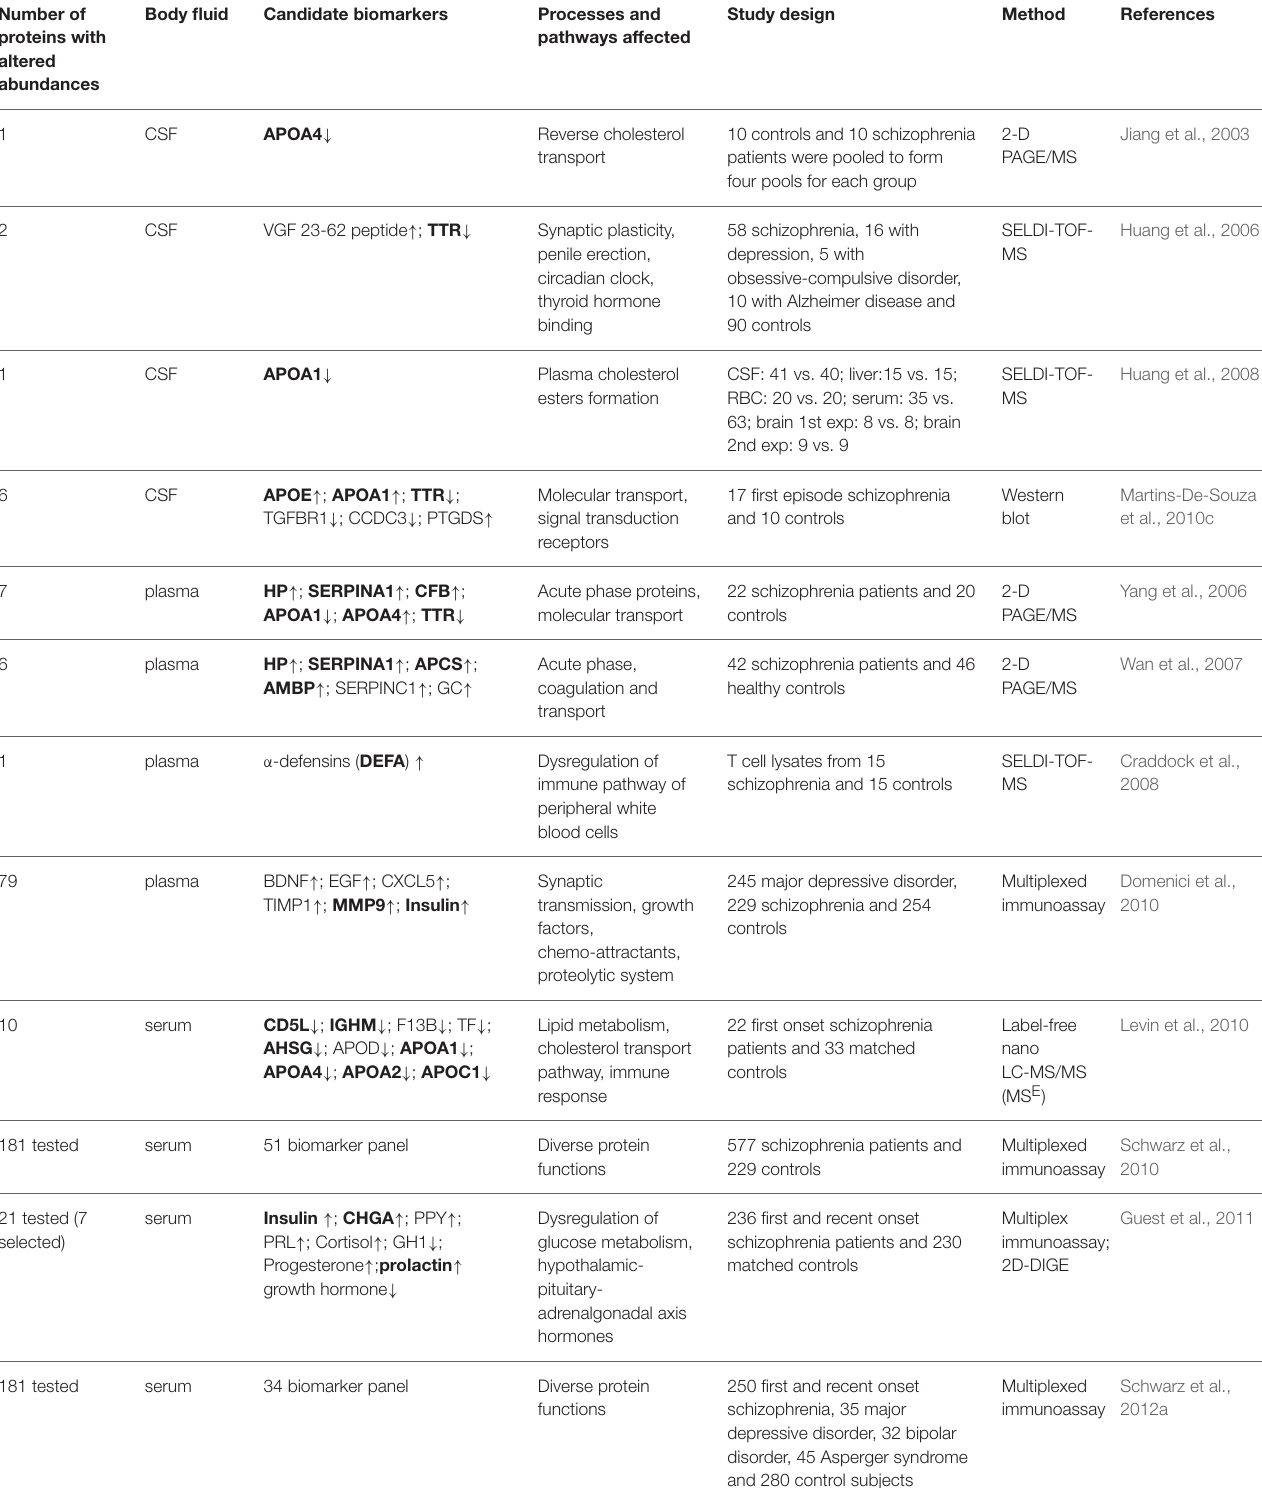
TABLE 2 | Candidate protein biomarkers for schizophrenia obtained by proteomics studies using human body fluids and tissues other than brain. Number of proteins